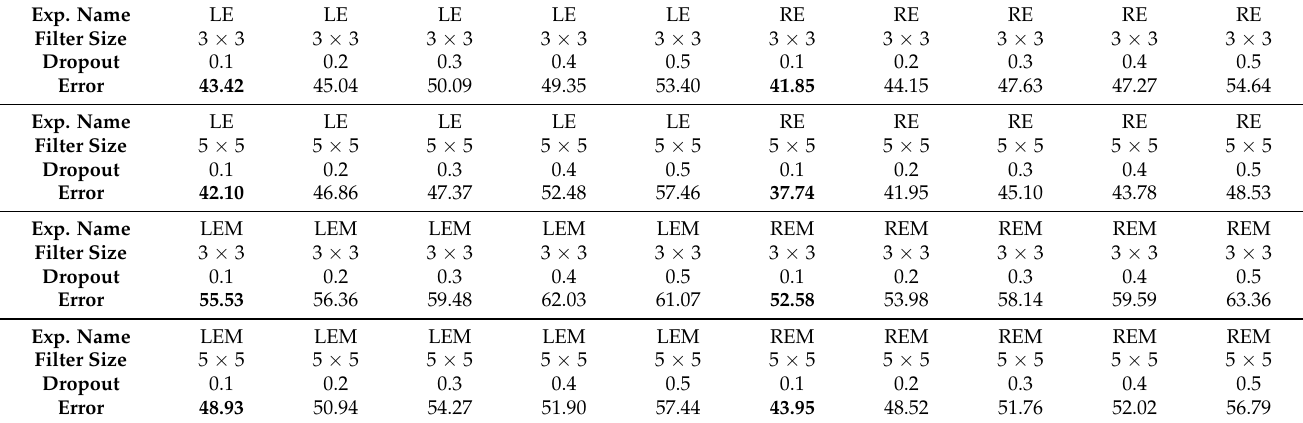
Table 3. Results of LE and and RE with and without a mask (learning rate = 0.001).